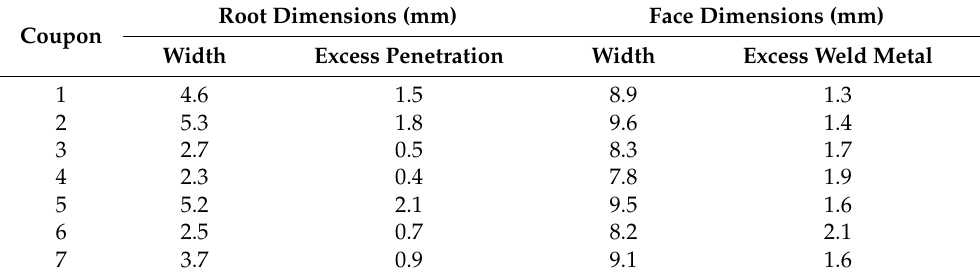
Table 3. Dimensions of all